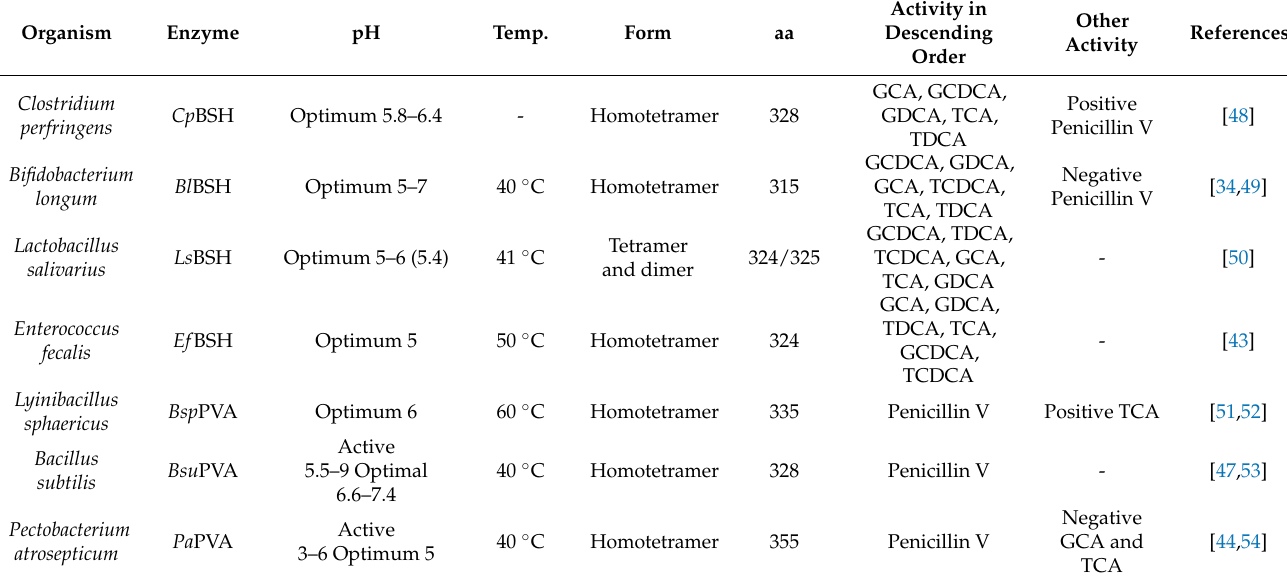
Table 1. Biochemical features of experimentally characterised CGH enzymes relevant to this review article. BSH activity towards bile salts is ranked in descending order. Bile salts screened include glyco- and taurocholic acid (GCA & TCA), glyco- and taurochenodeoxycholic acid (GCDCA and TCDCA) and glyco- and taurodeoxycholic acid (GDCA & TDCA). Organism Enzyme pH